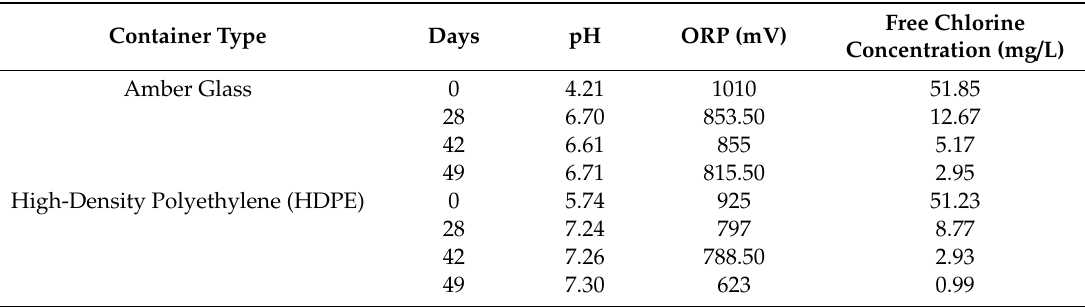
Table 1. pH, ORP, and FC concentration of ESW stored in both bottles at days 0, 28, 42, and 49.